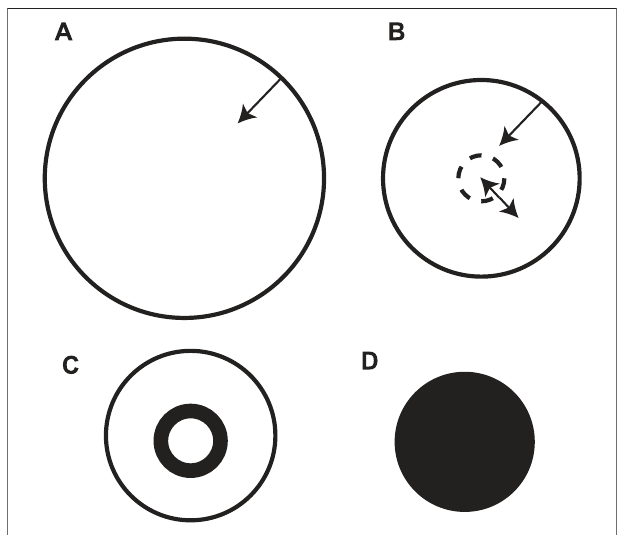
FIGURE 1 | (A) . The schematic representation of a collapsing spherical shell. The metric is Schwarzschild outside, and Minkowski inside. (B) . The shell/anti-shell pair is created with the radius R (cid:1) μ 2 . The positive energy shell 2 M falls to r = 0, while the negative energy one propagates outward to the incipient horizon. (C) . The region between the created shells (black ring) is growing, and it is not a fl at space anymore. Its time coordinate is re- synchronizedintotheSchwarzschildtime. (D) .Eventually,thenegativeenergy shell cancels out the original collapsing shell. A black hole is formed and the whole spacetime becomes Schwarzschild.